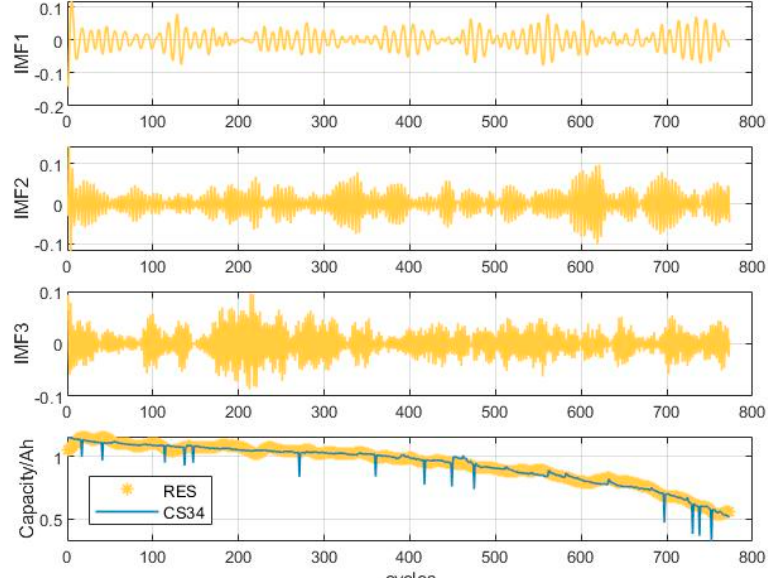
Figure 6. VMD result of CS34.